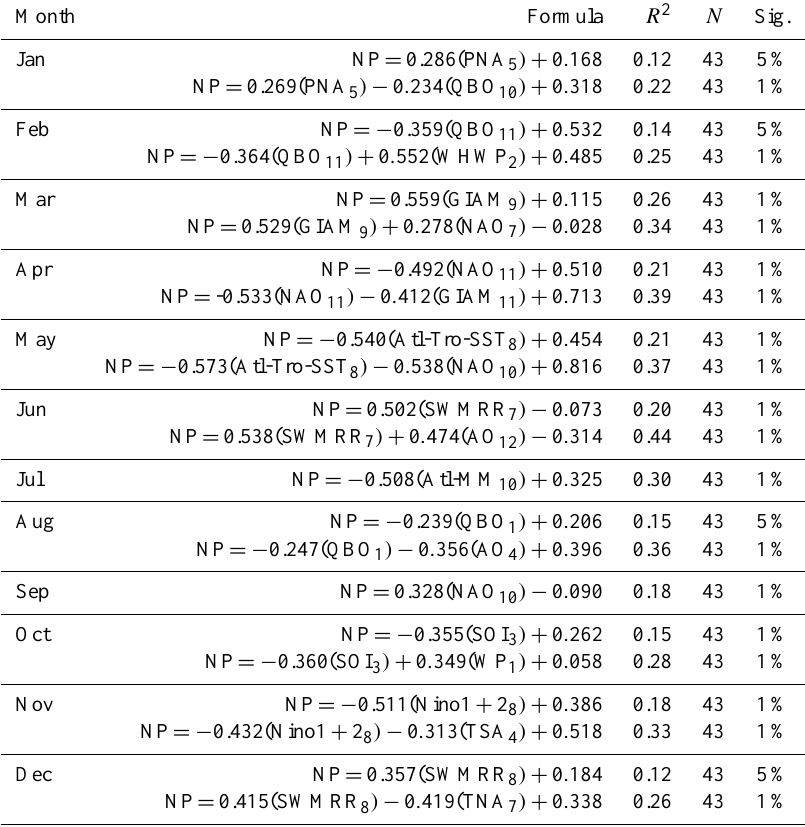
Table 7. Univariate and multivariate regression models for each month of a year. Month Formula R 2 N